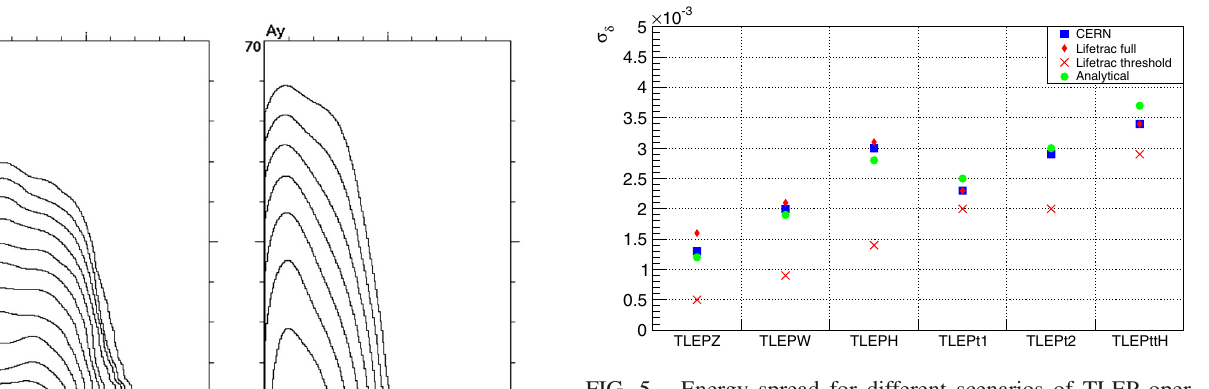
FIG. 5. Energy spread for different scenarios of TLEP oper- ation. Blue squares are taken from Table I, red diamonds are L IFETRAC results with full spectrum of beamstrahlung, red crosses are L IFETRAC results if beamstrahlung is considered for emission of photons with energy higher than acceptance, and green dots are our analytical